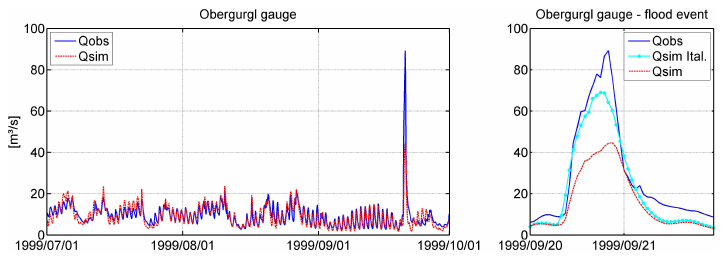
Fig. 3. Measured ( Q obs [m 3 /s]) and simulated ( Q sim [m 3 /s]) hydrographs of the Obergurgl gauge (72km 2 ) from 1 July until 30 September 1999 and a case study hydrograph with different precipitation input from an additional non-online station in Italy ( Q sim Ital. [m 3 /s]).